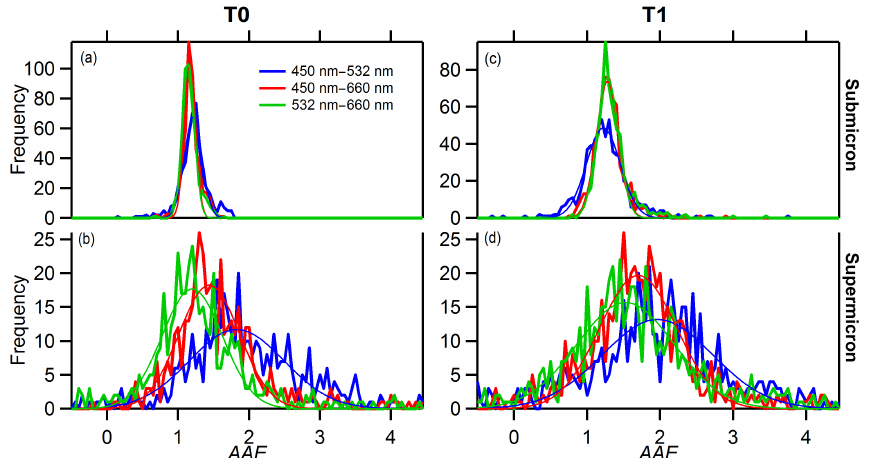
Figure 5. Histograms of the measured AAE values for various wavelength pairs for submicron (top; a and c ) and supermicron (bottom; b and d ) particles at the T0 (left panels) and T1 (right panels) sites. The different colors correspond to different wavelength pairs (see legend). The thick lines correspond to the observations while the thin lines show the results from fitting of the distributions to a Gaussian